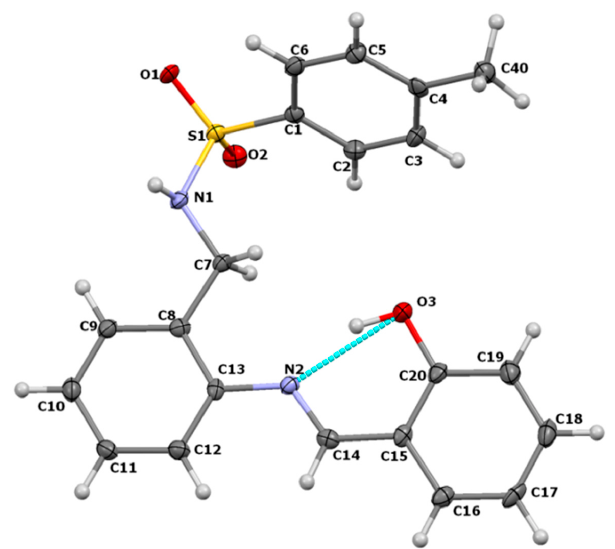
Figure 2. Ellipsoid view (50% probability) of the molecular structure of H 2 SB with the numbering scheme. The interaction between donor and acceptor atoms in the intramolecular H bond is represented as a dotted light blue line.